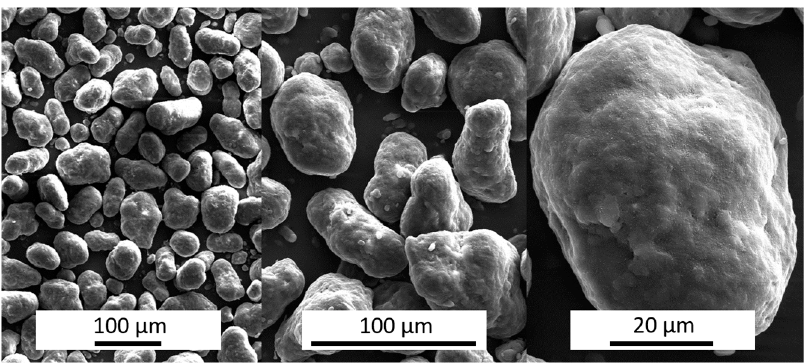
Figure 4. Scanning electron microscope (SEM) images of PA 12 Original powder at 200-, 500-, and 2000-fold magnification. and 2000-fold